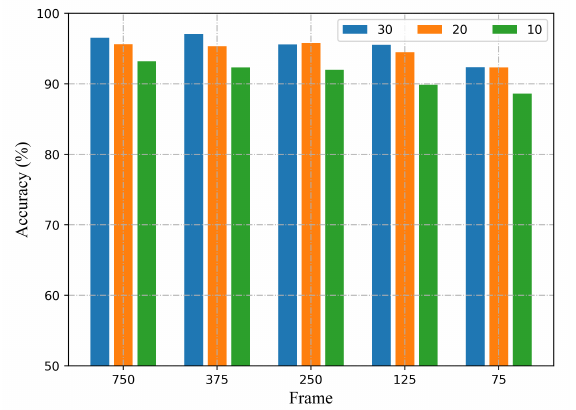
Figure 12. The recognition accuracy with different number of subcarriers and sampling rates.